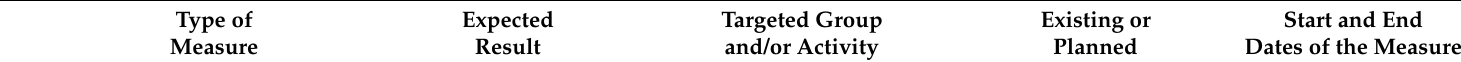
Table 7. Selected measures and policies of the Greek National Renewable Energy Action Plan